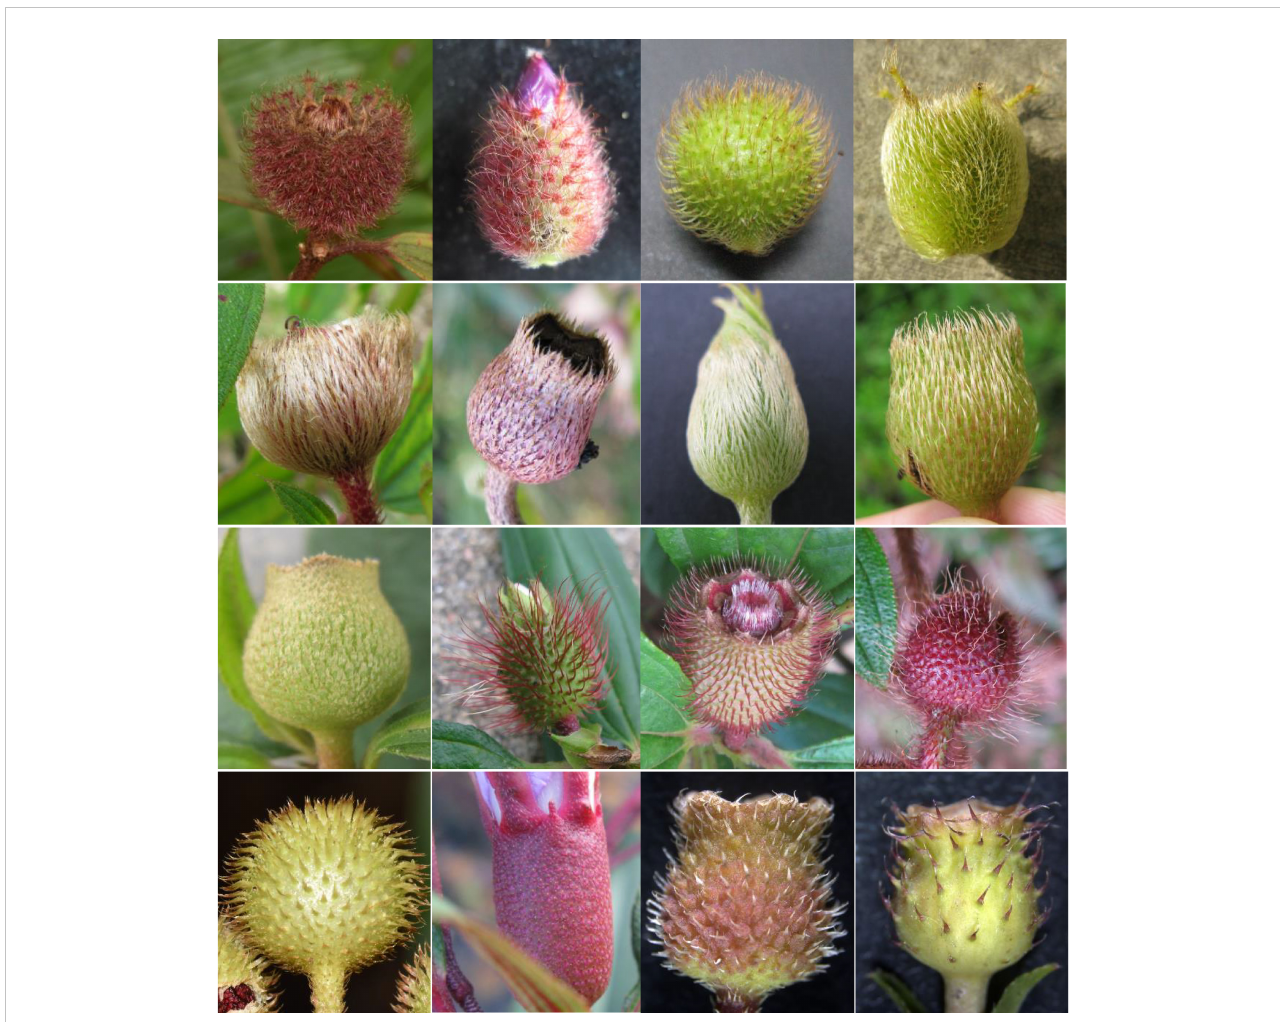
FIGURE 1 Trichomes on the hypanthia of Melastoma . From left to right, the fi rst row: Melastoma saigonense (Vietnam), M. beccarianum (Malaysia), M. dendrisetosum (China), M. ultrama fi cum (Malaysia); the second row: M. sabahense (Malaysia), M. normale (China), M. candidum (China), M. af fi ne (China),; the third row: M. setigerum (Indonesia), M. sanguineum (Cambodia), M. sanguineum (China), M. penicillatum (China); the fourth row: M. sp. (Vietnam), M. laevifolium (Malaysia), M. kudoi (China), M. dodecandrum